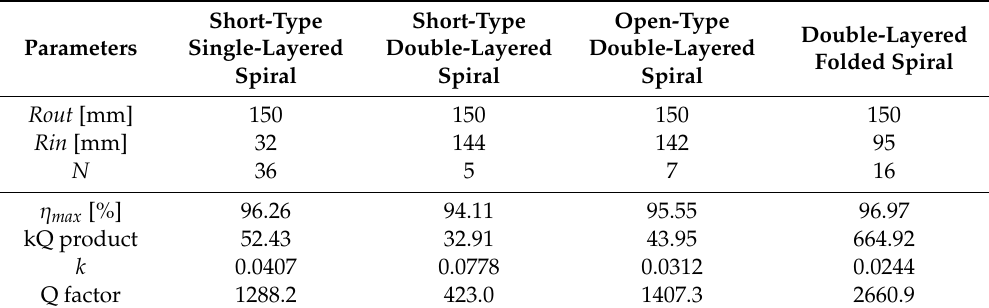
Table 2. Designed parameter and characteristics.